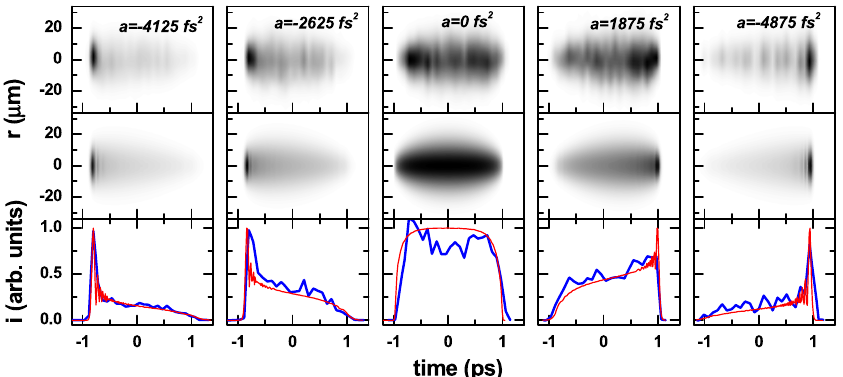
FIG. 10. (Color) Measured (top row), simulated (middle row) spatiotemporal distributions with different linear chirp in the main beam, and the intensity as a function of time at r ¼ 0 (bottom row; measured: bold lines; simulated: thin lines). Striations in the experiment data are due to the fluctuation of the laser pointing.